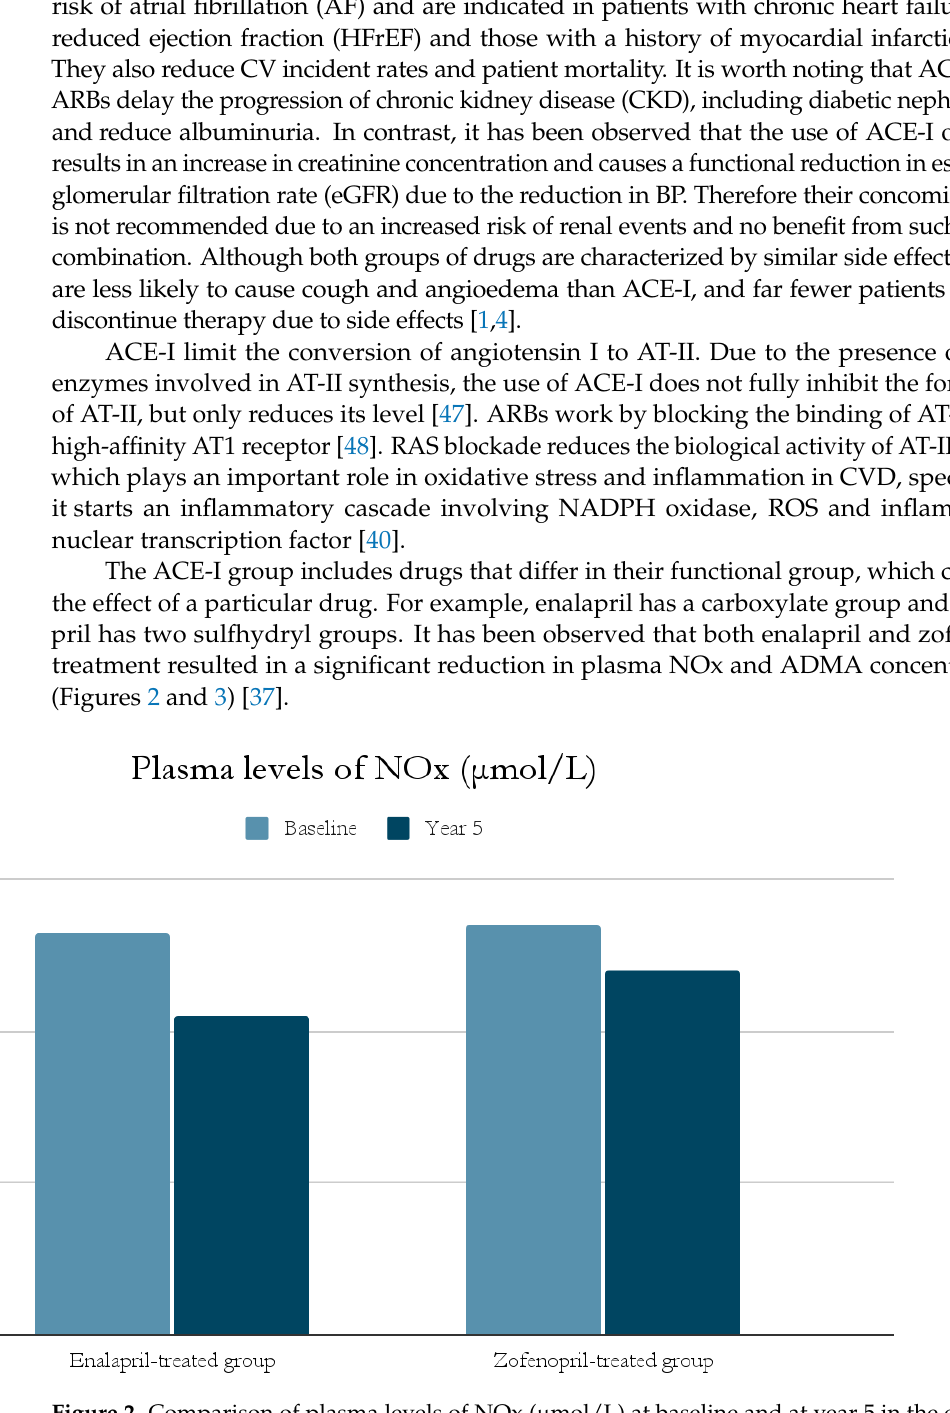
Figure 2. Comparison of plasma levels of NOx ( µ mol/L) at baseline and at year 5 in the enalapril and zofenopril groups. Newly diagnosed hypertensive patients (SBP > 160 mm Hg and/or DBP > 95 mm Hg) participated in the study. They were randomly assigned to receive enalapril (20 mg/d, n = 24) or zofenopril (30 mg/d, n = 24). Exclusion factors were additional risk factors for coronary artery disease or a history of ischemic events, as well as prior or concurrent therapy with ACE-I, antiplatelet agents or anticoagulants